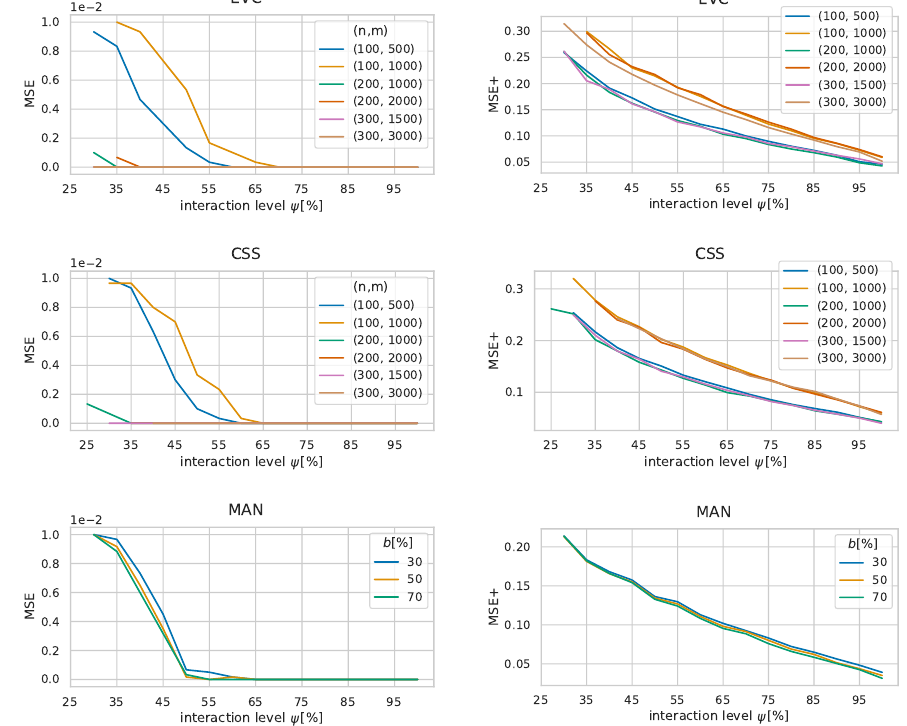
Figure 7. Development of average MSEs of ˜ w Θ over all so far unknown suitability values (left) and all so far unknown positive suitability values (right) for all benchmark